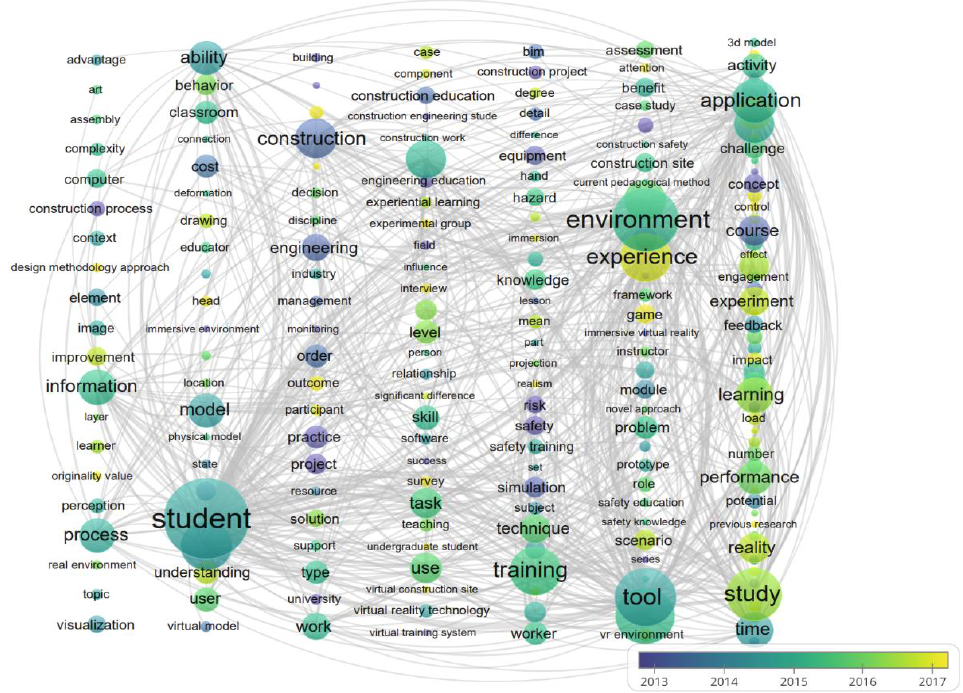
Figure 7. Mapping on-time visualization of abstract field co-occurrence in education and training.